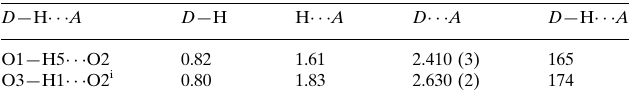
Hydrogen-bond geometry (A˚ , (cid:4)